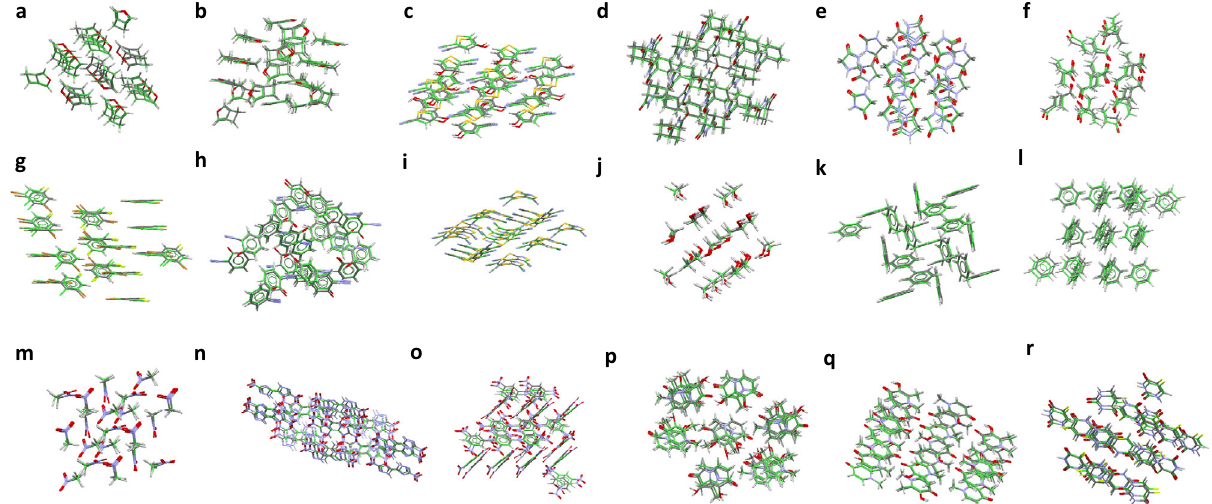
Fig. 2 Overlaps of crystal structures. Overlap of the experimental crystal structure (element-speci fi c colors) with the closest calculated crystal structure (green) using SAPT(DFT)-based aiFFs for systems: a and b I, c II, d IV, e VIII, f XII, g XIII, h XVI, i XXII, j methanol, k and l benzene, m nitromethane, n DNBT, o TNB, p and q Deferiprone, r Fluorouracil.